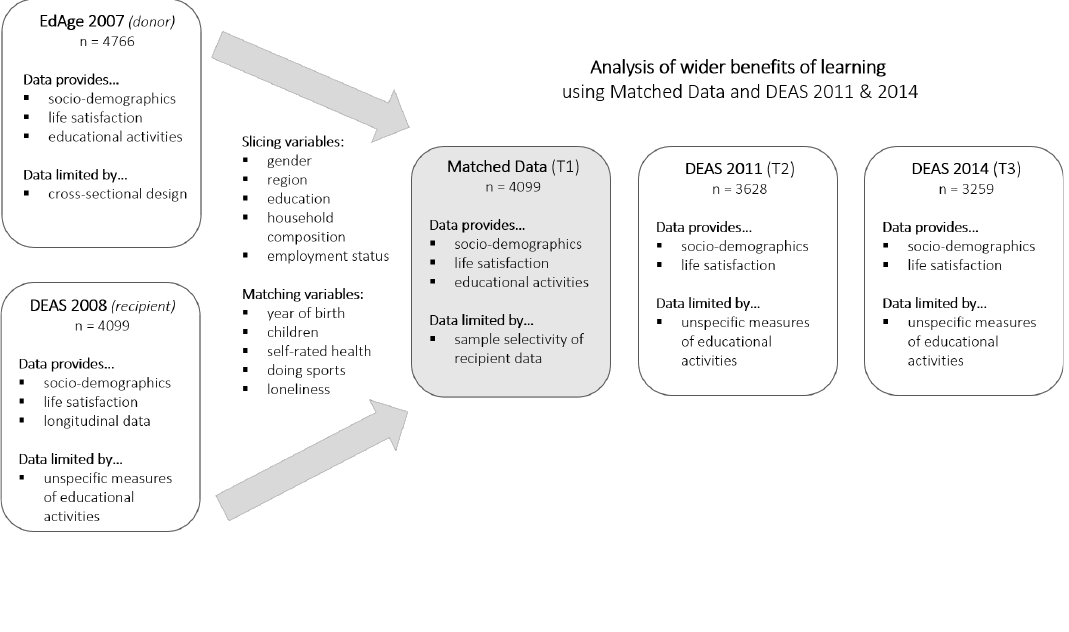
Figure 1: Statistical matching of DEAS 2008 and EdAge and follow-up analysis based